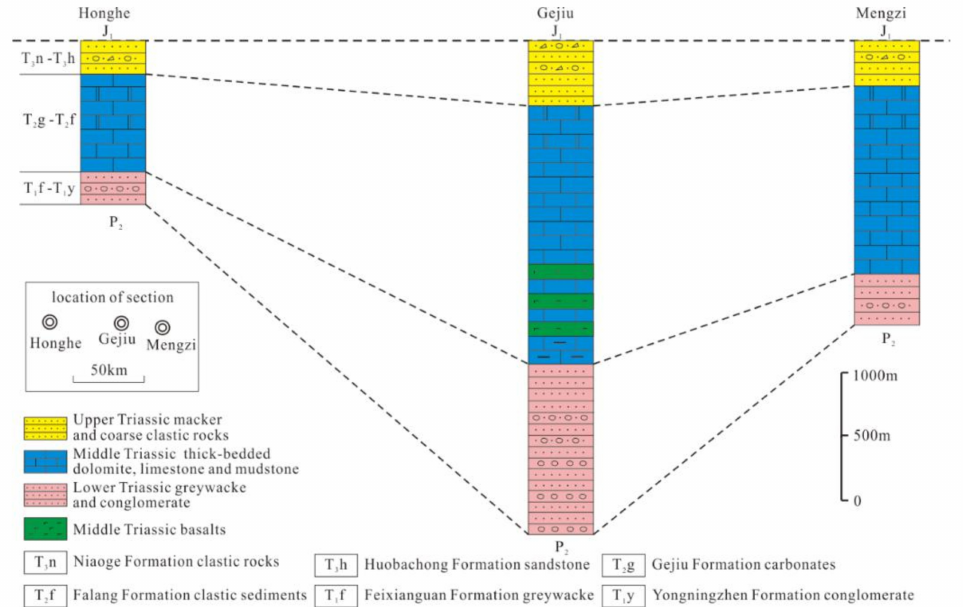
Figure 11. Stratigraphic correlation of the Triassic strata in the western South China block. The sedimentary data are from [3,18,73].